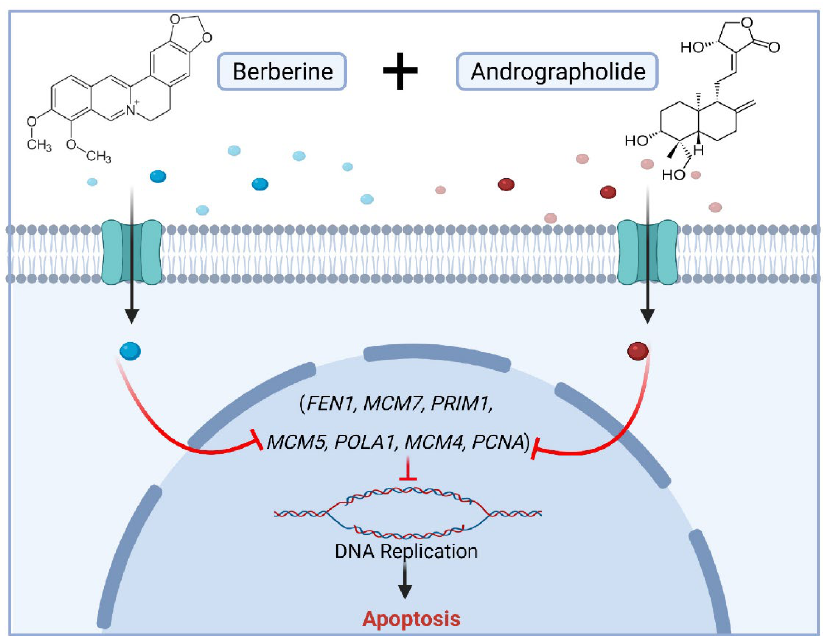
Figure 6. A schematic illustration of the berberine and Andrographis combination treatment showing enhanced anticancer activity by inhibiting DNA replication in CRC cells.